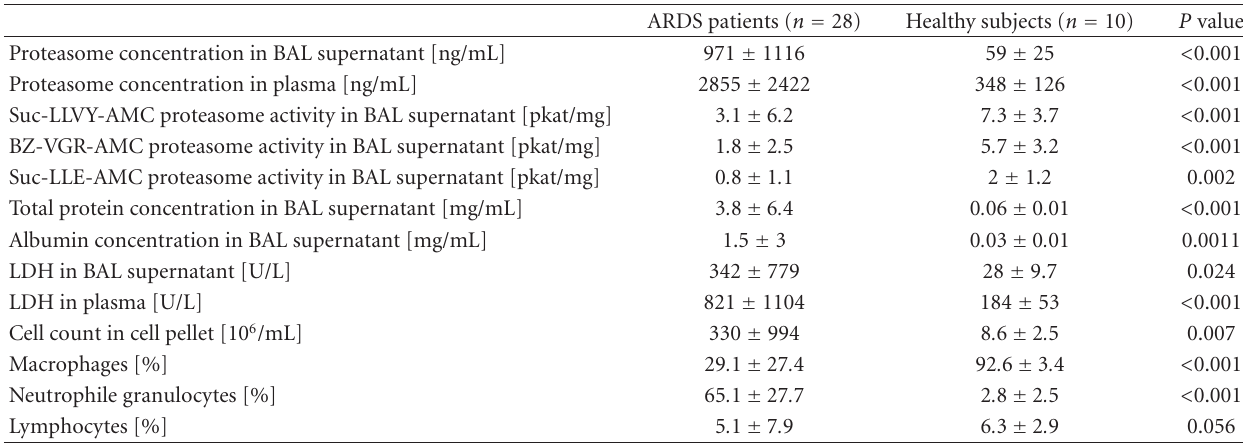
Table 3: Characteristics of BAL in ARDS and healthy